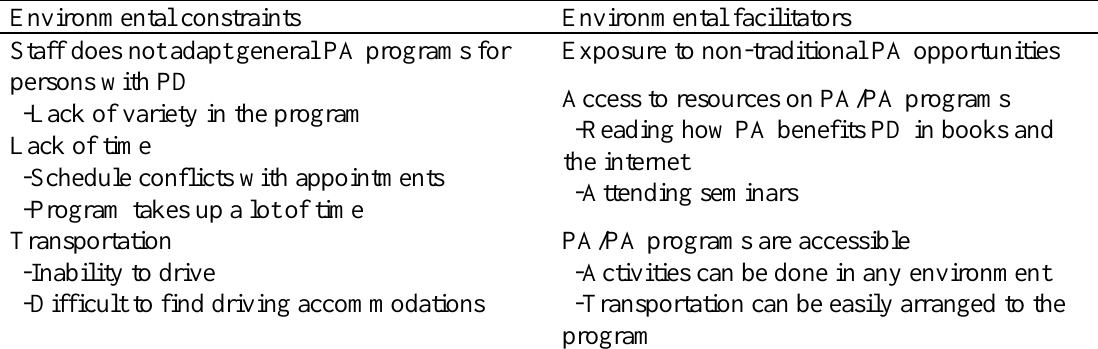
Table 4 Environmental factors influencing PA behaviour for individuals with